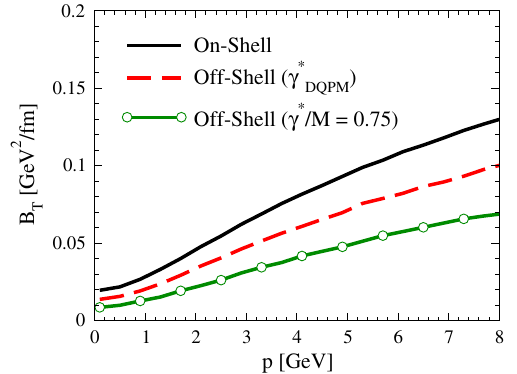
Fig. 7 Diffusion coefficient ( B T ) as a function of momentum and for fixedmediumtemperatureat T = 0 . 2 GeVforon-shellapproach(black solid line) and off-shell approach (red dashed line). The open green circles refers to the case with larger widths with fixed ratio γ ∗ 0 . 75